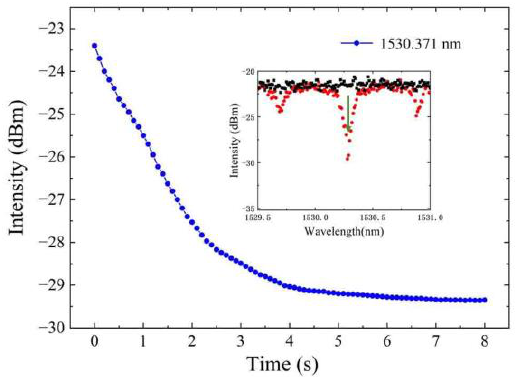
Figure 9. The response time with the pressure difference of 0.5